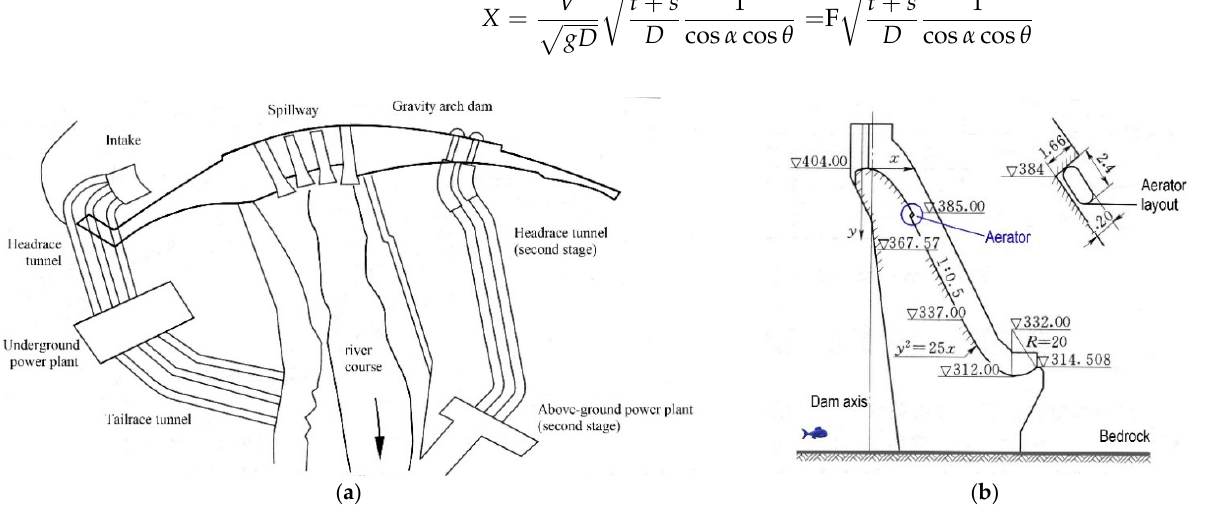
Figure 6. Baishan hydropower scheme. ( a ) dam layout; ( b ) longitudinal profile of chute spillway with aerator (adapted from [12]).